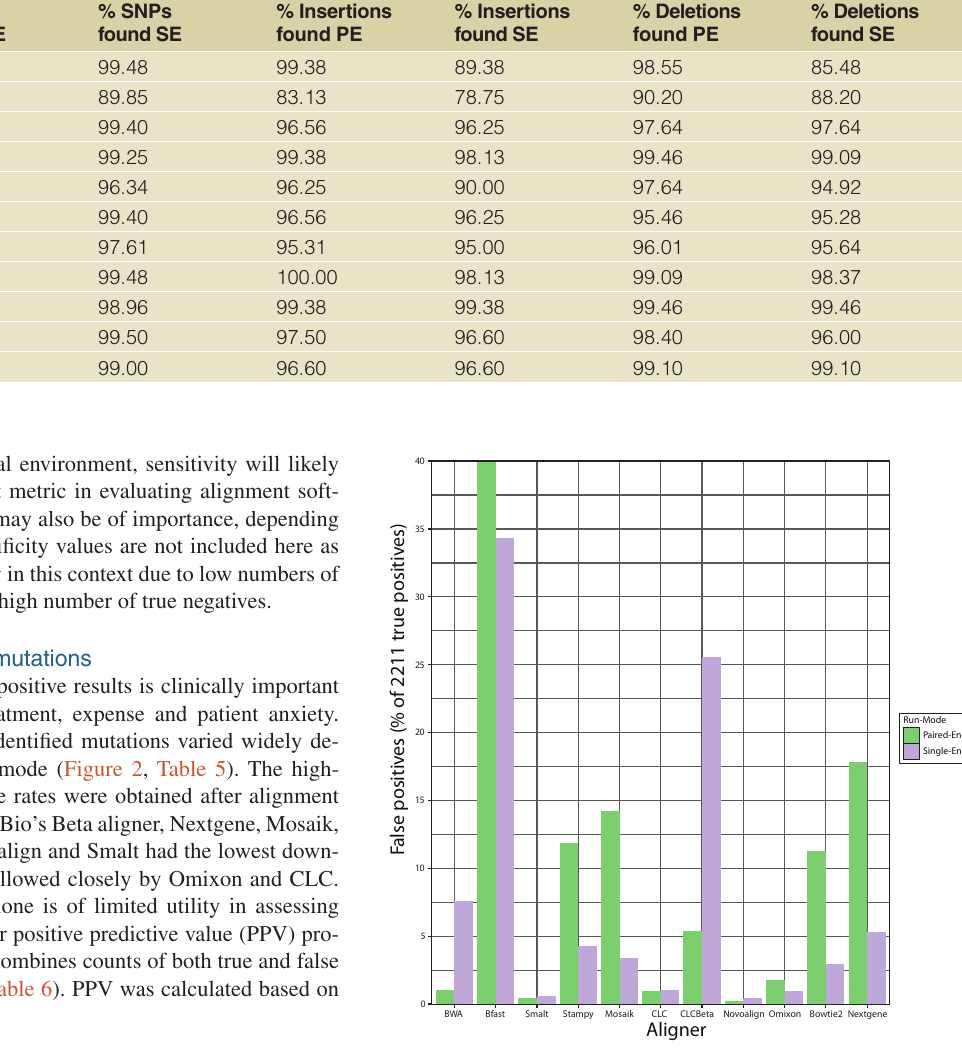
Figure 2. Graphical representation of the total number of downstream false positives expressed as a percentage of the true positive mutations detected following alignment with each each aligner in single and paired-end mode across 67 groups of simulated Illumina reads. Each read group contained 20 SNPs and 13